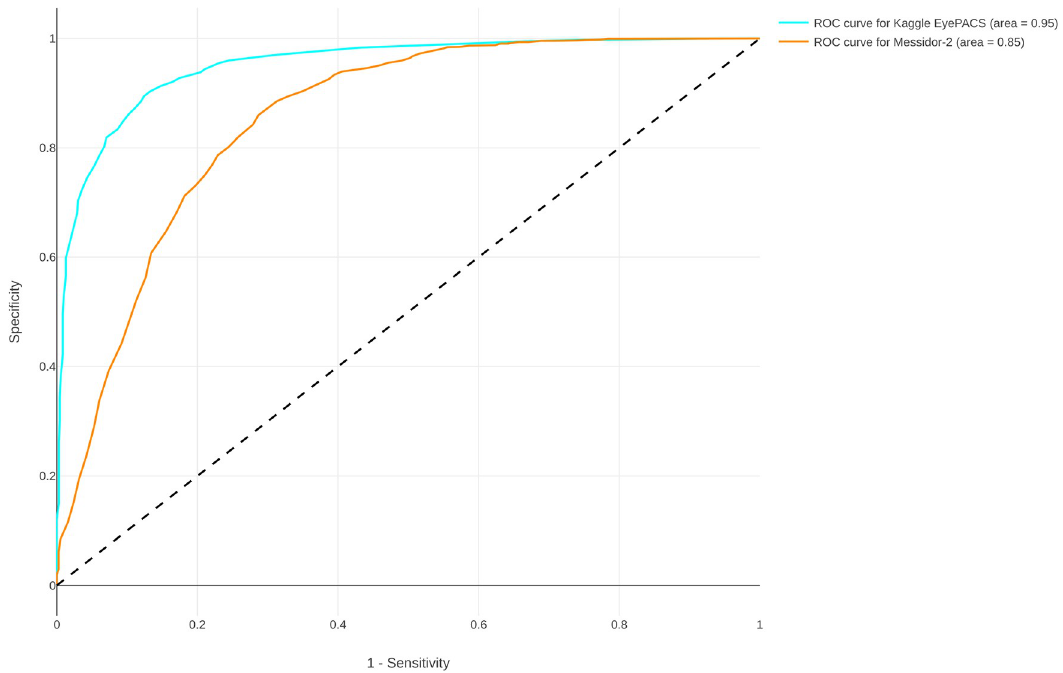
Fig 3. Reproduced results (AUC). Area under receiver operating characteristic curve for the reproduced algorithm. https://doi.org/10.1371/journal.pone.0217541.g003 Table 1. Reproduced results. Performance on test sets of reproduction, compared to results from the original study. The results of the original study are depicted in parenthesizes. Reproduced